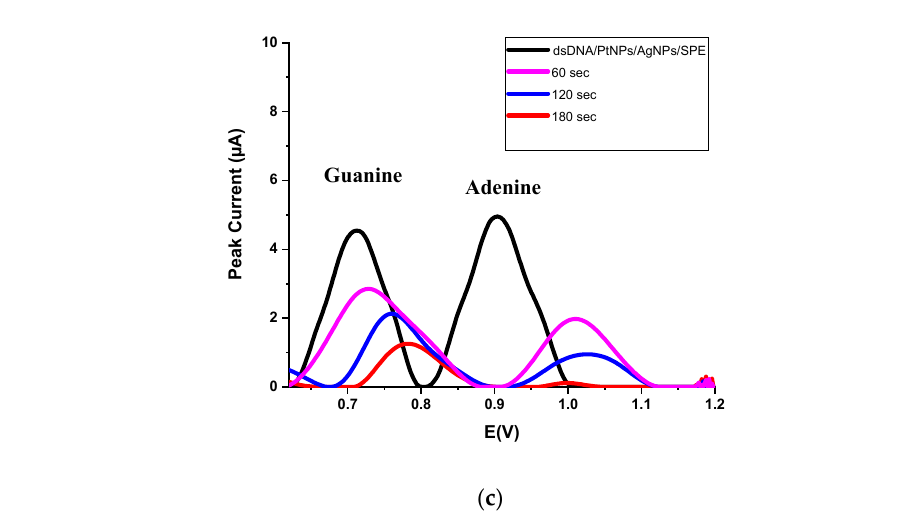
Figure 8. The effect of the binding time of 0.5 ppm DOX on the signals of ( a ) dGuo and ( b ) dAdo; and ( c ) DP voltammograms of dsDNA/PtNPs/AgNPs/SPE (black) with a different binding time of DOX in pH 4.70 AB; 60 s (pink), 120 (blue), 180 s (red).